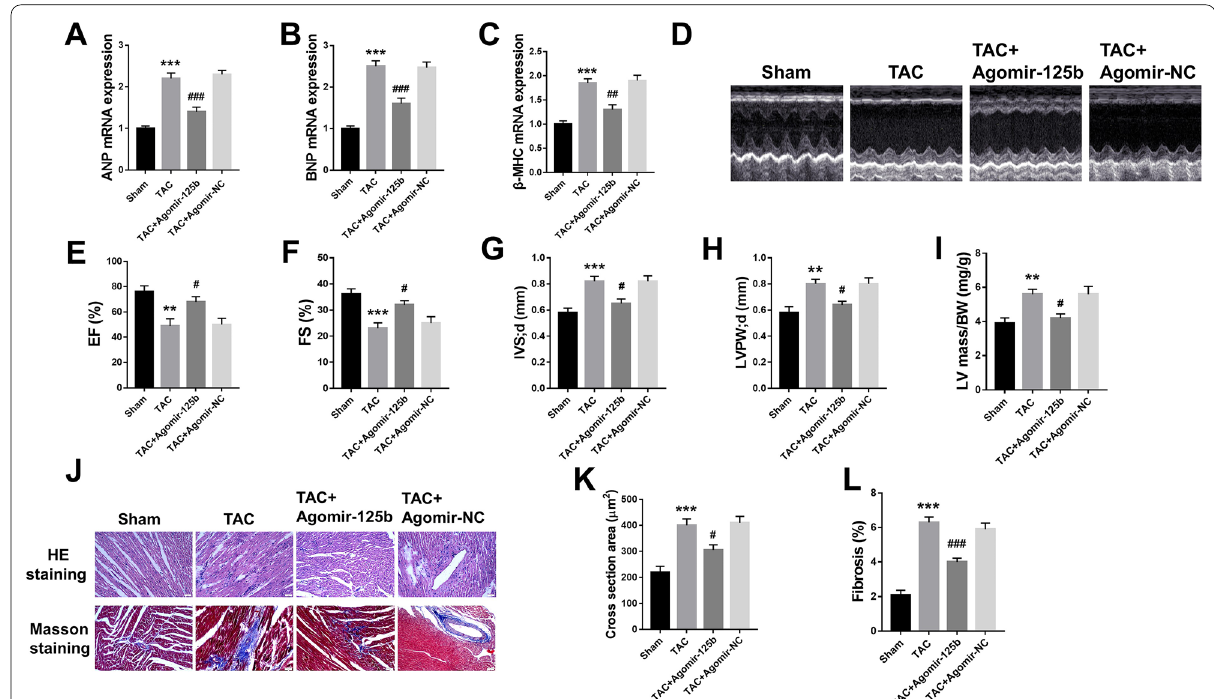
Fig. 2 MiR-125b overexpression alleviated cardiac function injury in HF mice. Mice were treated with or without TAC, then TAC mice were tail intravenously injected with agomir-125b or agomir-NC. A – C The mRNA levels of ANP ( A ), BNP ( B ) and β-MHC ( C ) were evaluated by qRT-PCR (n 5). = D Representative images of echocardiographic measurements of mouse hearts (n 8). E Left ventricular ejection fraction (EF%) (n 8). F Left = = ventricular fractional shortening (FS%) (n 8). G Left ventricular septal thickness; diastole (IVS; d) (n 8). H Left ventricular posterior wall thickness; = = diastole, (LVPW; d) (n 8). I Left ventricular mass/body weight (LV mass/BW) (n 8). J Representative images of H&E staining and Masson staining = = of mouse heart tissues (n 8). K The statistical result of H&E staining (n 5). L The statistical result of Masson staining (n 5). * p < 0.05, ** p < 0.01, *** = = = p < 0.001 vs. sham group; # p < 0.05, ## p < 0.01, ### p < 0.001 vs. TAC